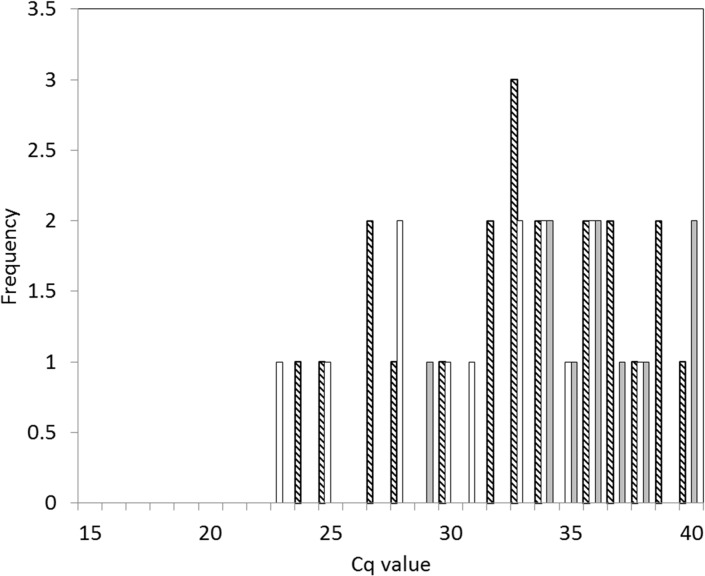
Frequency histogram of responses of Cx. pipiens lines to attempted infection with Schmallenberg virus.Black = Intrathoracically inoculated Brookwood line; Cross-hatch = Orally fed Brookwood line; White = Orally fed Caldbeck line; Grey = Orally fed Netherlands line. Samples of >40 Cq are excluded.